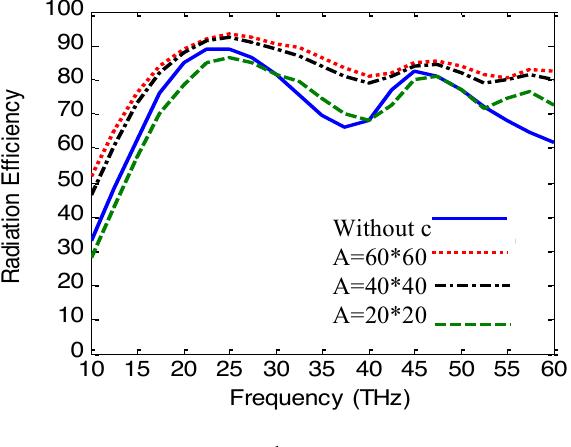
b. Figure 15a. The electric field variation versus frequency for rhombic dipole IR - nanoantenna with different overlapping area using insulator of 𝜀 =8, b. The radiation efficiency ! variation versus frequency for rhombic dipole IR -